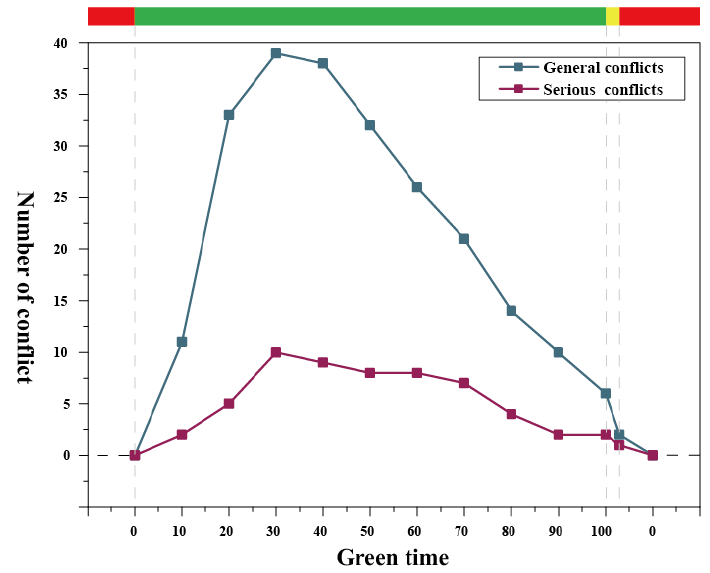
Figure 14. Overall conflict distribution of Type 2.